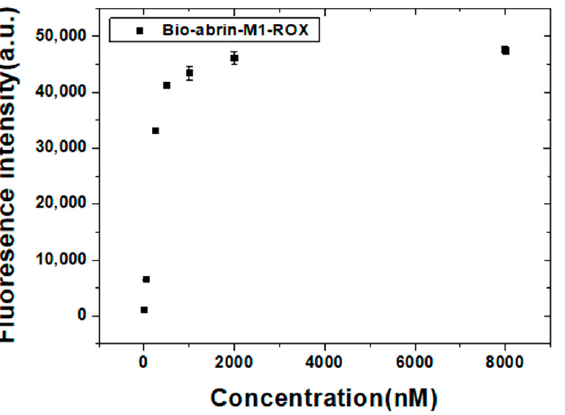
Figure 9. The fluorescence intensity of streptavidin-coated magnetic microspheres combined with different concentrations of biotin and ROX labeled abrin-M1.